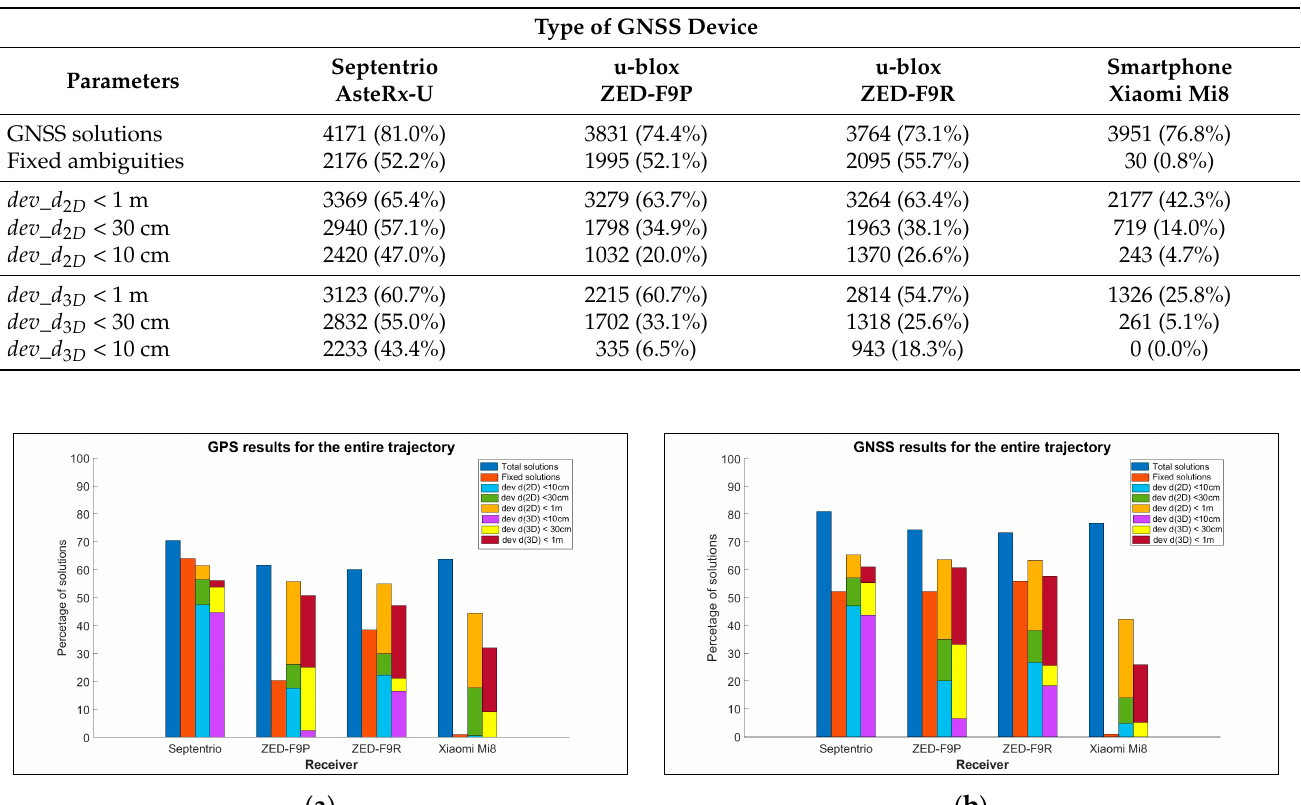
Table 4. GNSS solutions, solutions with fixed ambiguities, and deviation of distances below the given threshold. Situation: entire trajectory (static and kinematic: total solutions 5148).